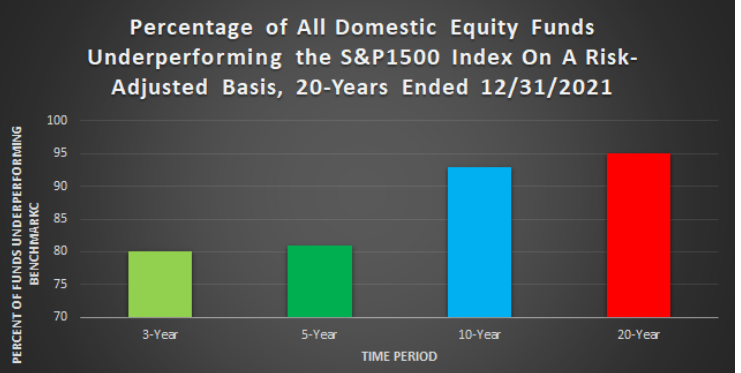
Figure 4. SPIVA research results on active funds vs. index benchmarks over the 20-year period ending 31 December 2021. Measured on a risk-adjusted return basis, a staggering 95% of all domestic equity funds underperformed a key benchmark (S&P 1500) over the 20-year period. Even when measured in absolute terms, that figure is still 90%. Finally, similar results hold in all categories of managed funds underperforming their respective benchmarks (Coleman